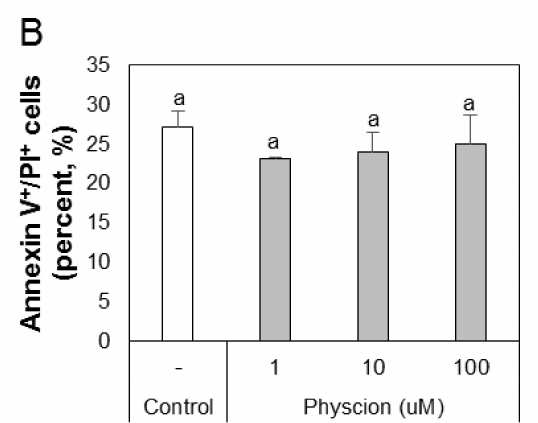
Figure 1. Physcion was not cytotoxic to bone-marrow-derived dendritic cells (BMDCs). ( A ) Cell death analysis by flow cytometry. Late-stage apoptotic cells are presented (Annexin V-FITC positive and